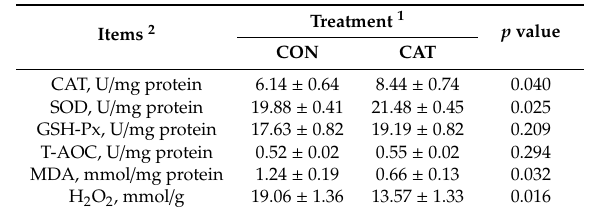
Table 3. E ff ects of dietary exogenous catalase supplementation on jejunum mucosa antioxidant parameters in weaned piglets.